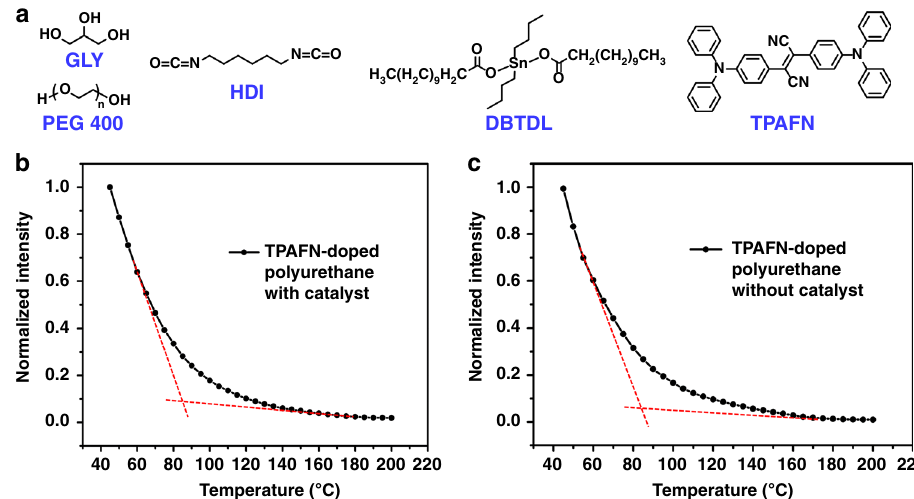
Fig. 4 Detecting T v of polyurethanes by AIE-probe technique. a Synthesis of polyurethane. b The fl uorescence intensity plot of 0.1 wt% TPAFN-doped polyurethane at a series of temperature at 633 nm (Excitation: 527 nm). All the fl uorescence intensities are normalized to 45 °C. c The fl uorescence intensity plot of 0.1 wt% TPAFN-doped polyurethane without DBTDL catalyst at a series of temperature at 633 nm (Excitation: 527 nm). All the fl uorescence intensities are normalized to 45